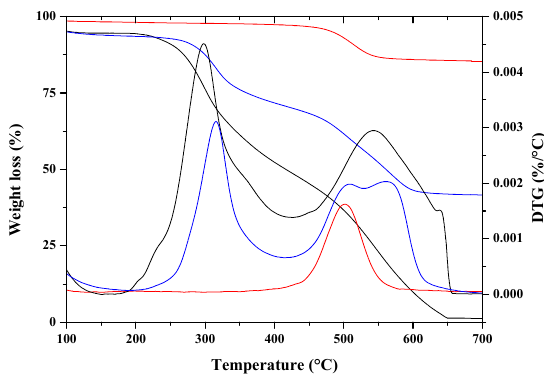
Figure 2. TGA/DTG of: HNTs ( Figure 2. TGA/DTG of: HNTs ( ), Lysozyme ( ), nano ‐ hybrid HNTs/Lysozyme ( ). Figure 2. TGA/DTG of: HNTs ( ), Lysozyme ( ), nano ‐ hybrid HNTs/Lysozyme ( ). Figure 2. TGA/DTG of: HNTs ( ), Lysozyme ( ), nano ‐ hybrid HNTs/Lysozyme ( ). Figure 2. TGA/DTG of: HNTs ( ), Lysozyme ( ), nano ‐ hybrid HNTs/Lysozyme ( ).